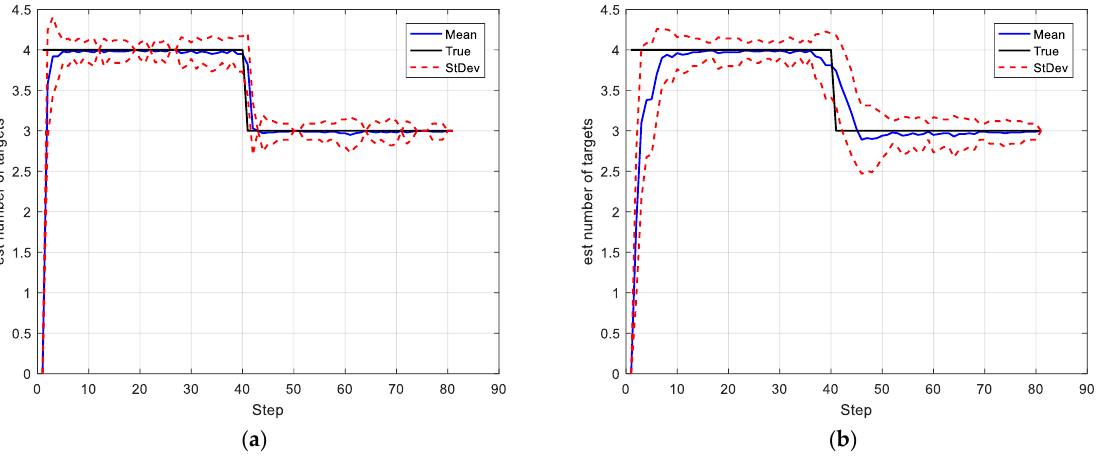
Figure 4. The standard deviation range value and the mean value of the estimated number of targets of IGGM-PMBM filter ( a ) 𝑃 𝐷 = 0.94 , 𝜆 𝜅 = 10 ; ( b ) 𝑃 𝐷 = 0.68 , 𝜆 𝜅 = 10 .